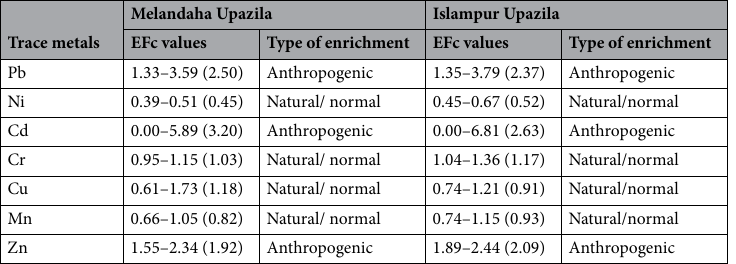
Table 5. Summary statistics for enrichment factors (EFc) calculated for selected trace elements in soils of brinjal-producing areas of Jamalpur district, Bangladesh. Value in parenthesis indicates the study average.